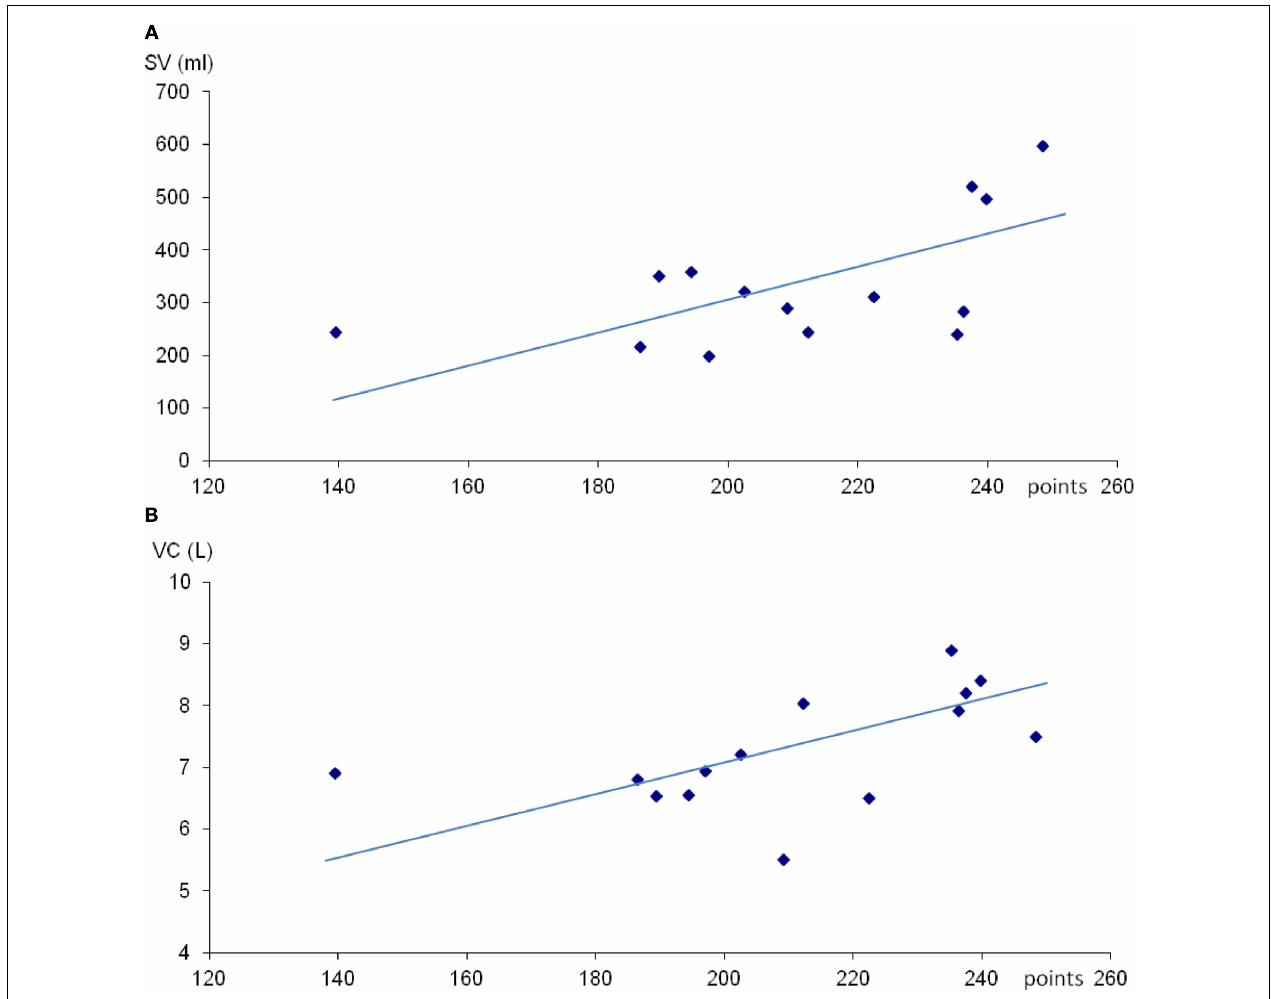
FIGURE 1 | Scatter diagram of spleen volume (SV;A) and vital capacity (VC; B) against total points in apnea competition. For (A) , r = 0.57 and for (B) , r = 0.54 (both P <